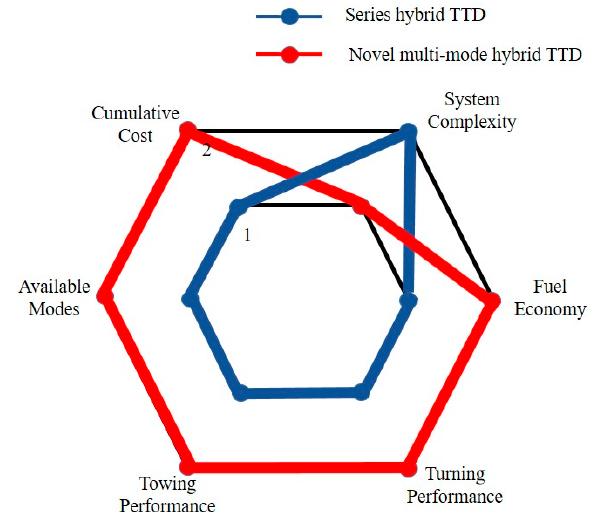
Figure 18. Radar map comparison of the novel multi-mode hybrid track-type dozer (TTD) and series hybrid TTD.